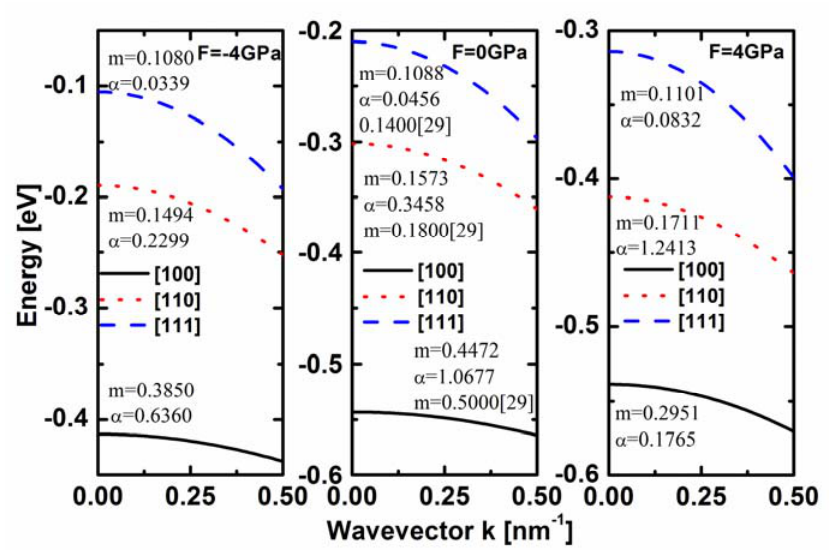
Figure 3. The energy dispersion relations for the first subband of the simulated strained and unstrained SiNWs with various channel orientations. T